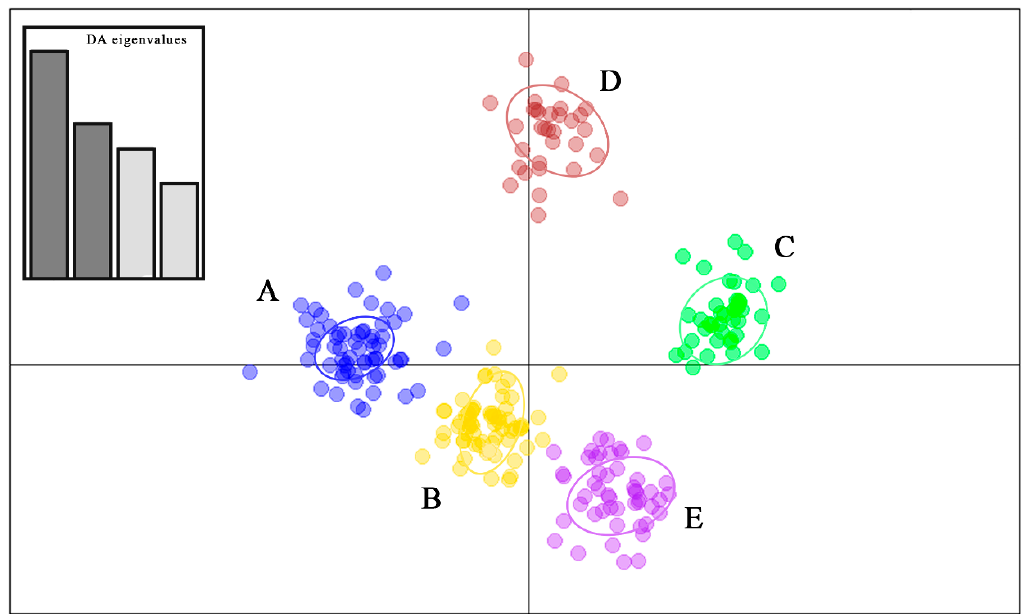
Figure 2. Discriminant Analysis of Principal Components (DAPC) for microsatellite data of the five clusters ( A – E ) of Emys trinacris . The oval outlines correspond to 95% confidence intervals. (DA Eigenvalues: 891, 606.9, 455.1, 326).